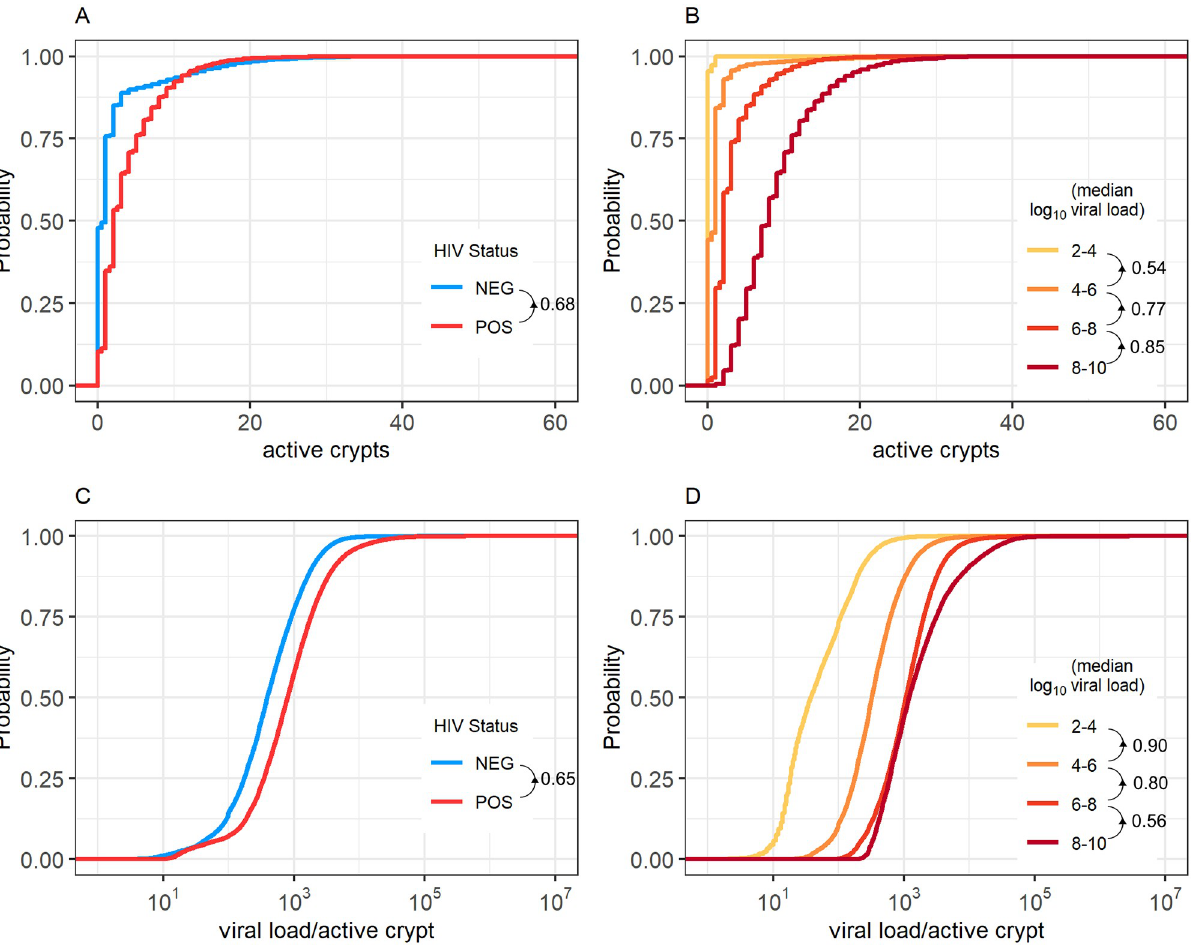
Fig 7. Predicted numbers of active crypts and viral load per active crypt. Cumulative distributions of the median number of crypts actively producing EBV (A and B) and the median EBV viral load produced by an active crypt at any given time (C and D) are shown stratified by participant HIV-1 status and EBV median viral load in the saliva. Increases in median salivary EBV viral load are caused by a higher number of crypts having active (B) and more extensive (D) infection. This trend translates to HIV-1 coinfected participants having more infected crypts infected, and each infected crypt producing more virus. We see that HIV-1 uninfected individuals usually have more actively infected crypts and more virus per active crypt than HIV-1 coinfected individuals. Similarly, we see that individuals with higher median viral loads in their saliva usually have more actively infected crypts and more virus per active crypt than individuals with lower median viral loads. Directional arrows and numbers by figure legends indicate the probability that a randomly selected individual of one group has a higher parameter value (be it the number of active crypts or the viral load per active crypt) compared with a randomly selected individual in a second group. Arrows show the direction of